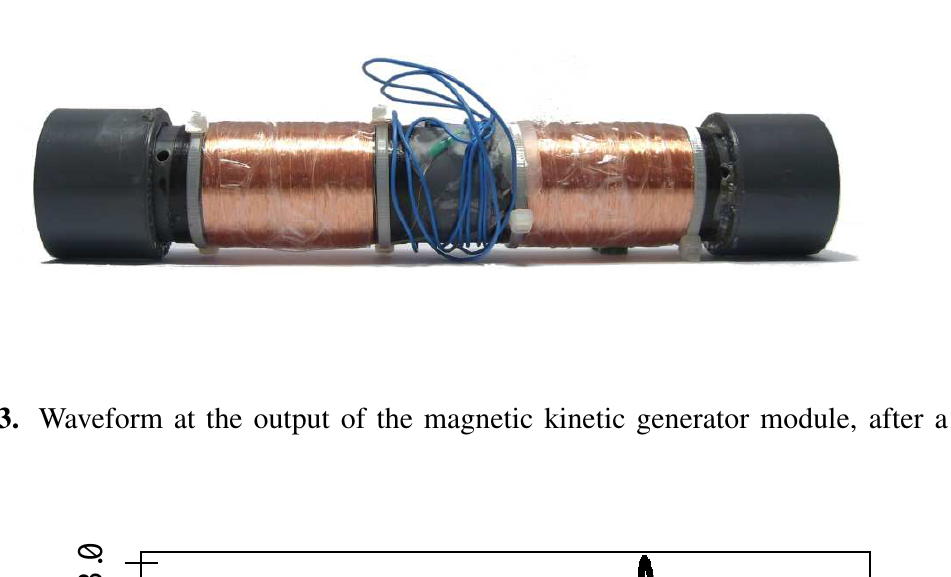
Figure 2. The magnetic kinetic generator module.